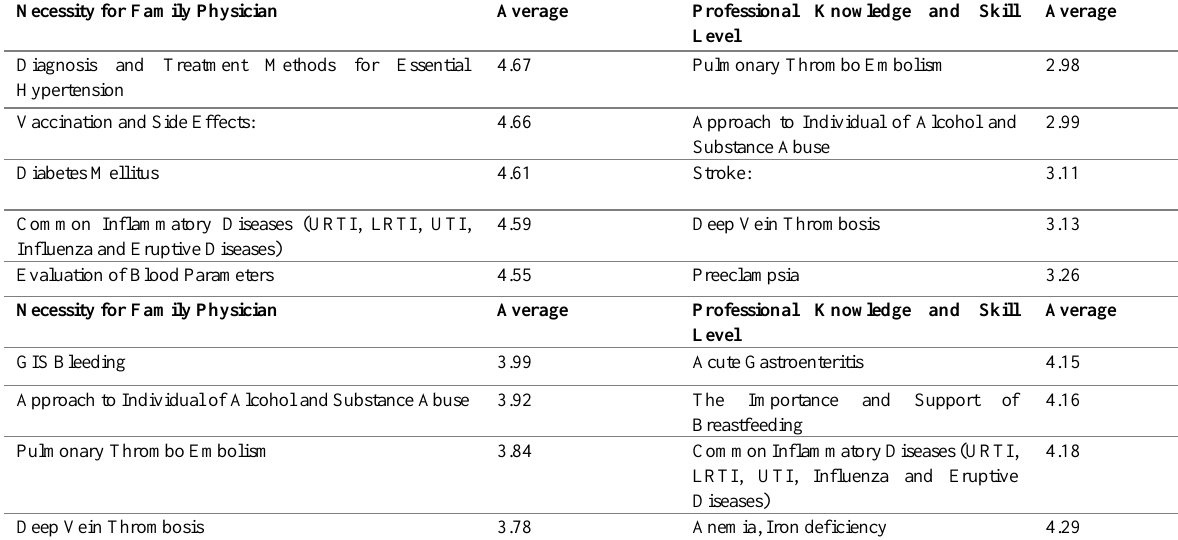
Table 23: The Necessity of Professional Development for Family Physicians and Comparison of Professional Knowledge and Skill